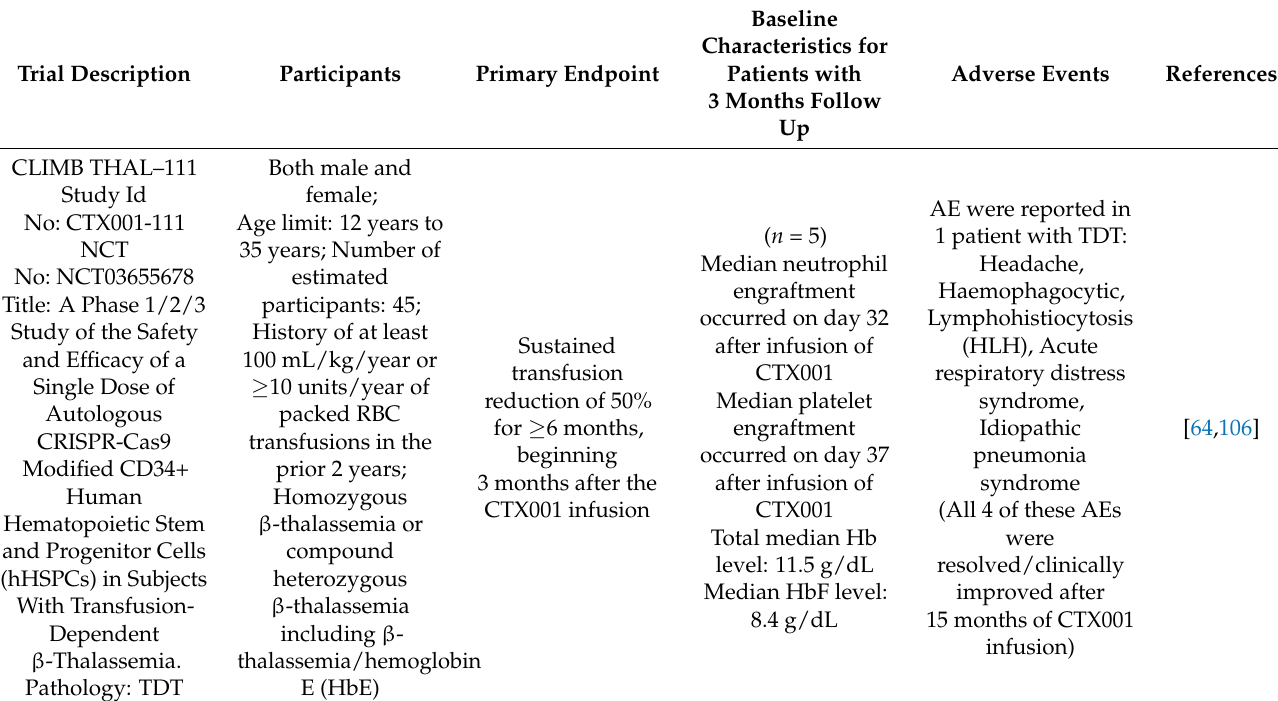
Table 1. Details of the pivotal clinical trials utilizing CRISPR/Cas9 gene therapy for β -hemoglobinopathies.